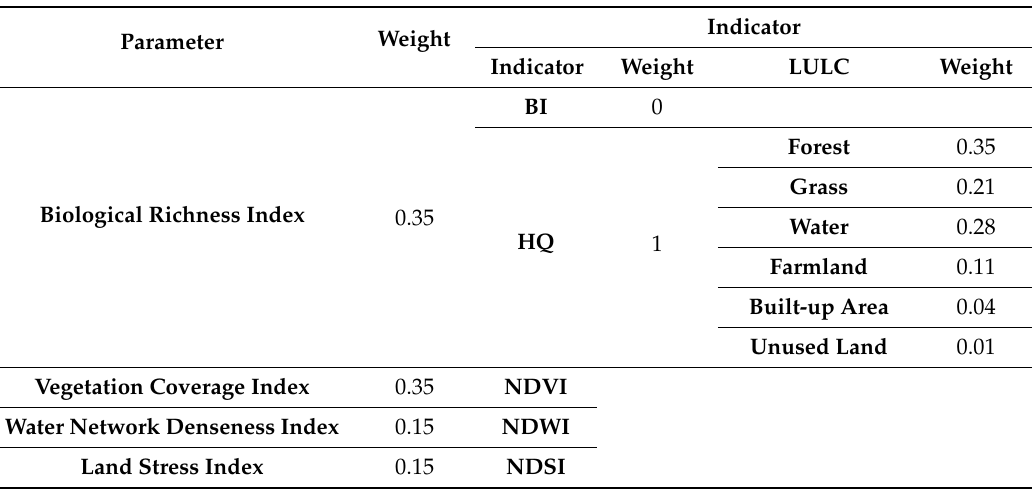
Table 4. Weights of each indicator for calculating